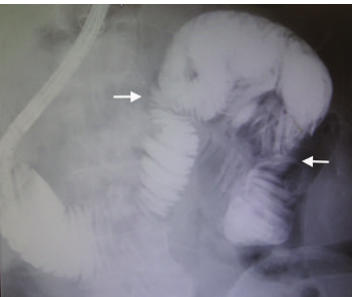
Figure 3: A gastrointestinal series with barium contrast showing dilated loops of the small bowel in the upper quadrant, delay of contrast, or the point of obstruction